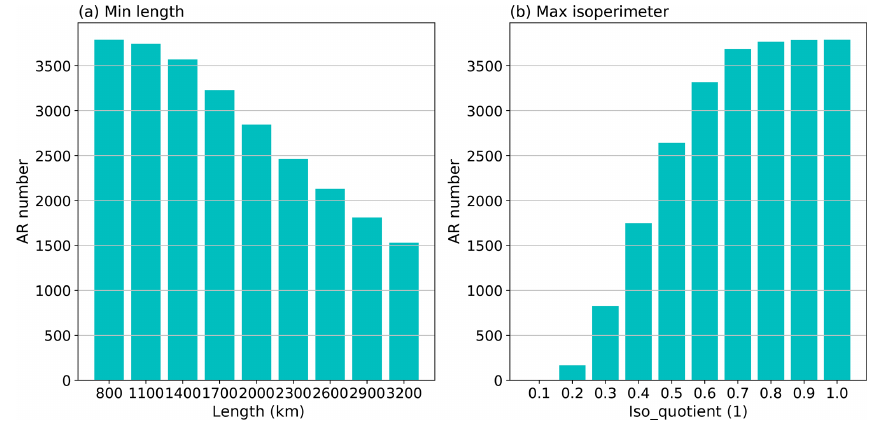
Figure A5. (a) Average seasonal (November–April) AR numbers in the Northern Hemisphere during November 2004 to April 2010 when different minimum length criteria are applied. (b) Average seasonal AR numbers in the same time period when different maximum isoperi- metric quotient criteria are